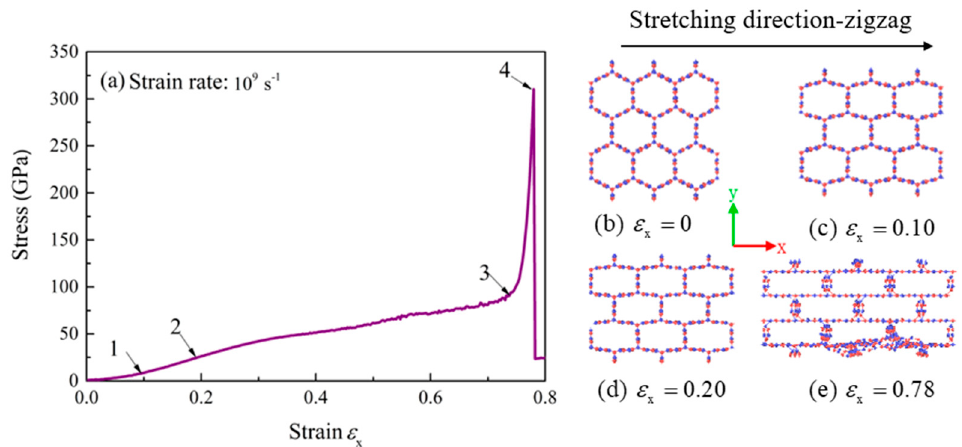
Figure 3. ( a ) The stress-strain curve of BNHCs under tensile loading along the zigzag direction; ( b )–( e ) Deformation of BNHCs under different tensile strains along the zigzag direction.